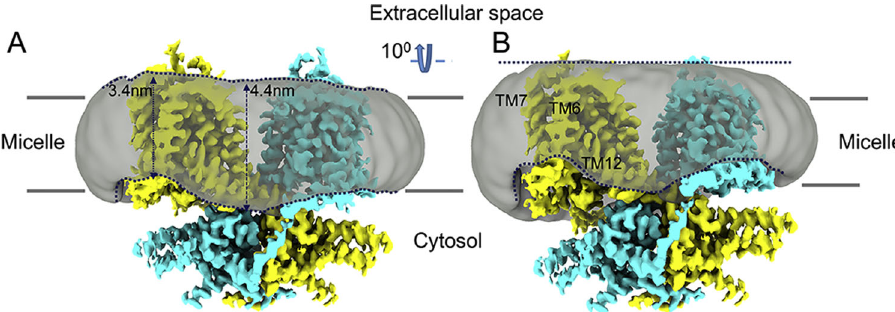
Fig. 5 Interaction between prestin and the surrounding micelle. A Cryo-EM map for the gerbil prestin structure (colored by subunit in cyan and yellow, respectively) showing the surrounding micelle as a gray transparent surface. The dashed line (in navy) follows the micelle ’ s boundaries. The micelle belt around the transmembrane domain of prestin is locally distorted (thinned) at the cytosolic side close to TM6 and TM12 helices. The approximate thickness of the micelle in these regions is indicated by black arrows. The transmembrane helices 6, 7, and 12 are labeled. B As in ( A ) but tilted by ~10° to better illustrate the micelle ’ s distortions at the cytosolic side. See also Supplementary